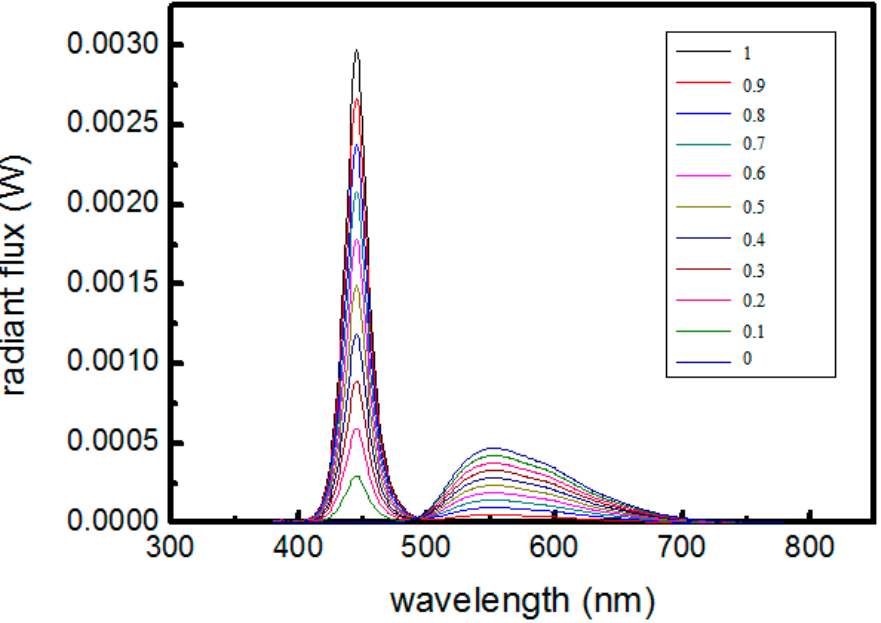
Figure 4. Calculated results for different leakage fractions. Table 1. Calculated results for different leakage fractions.